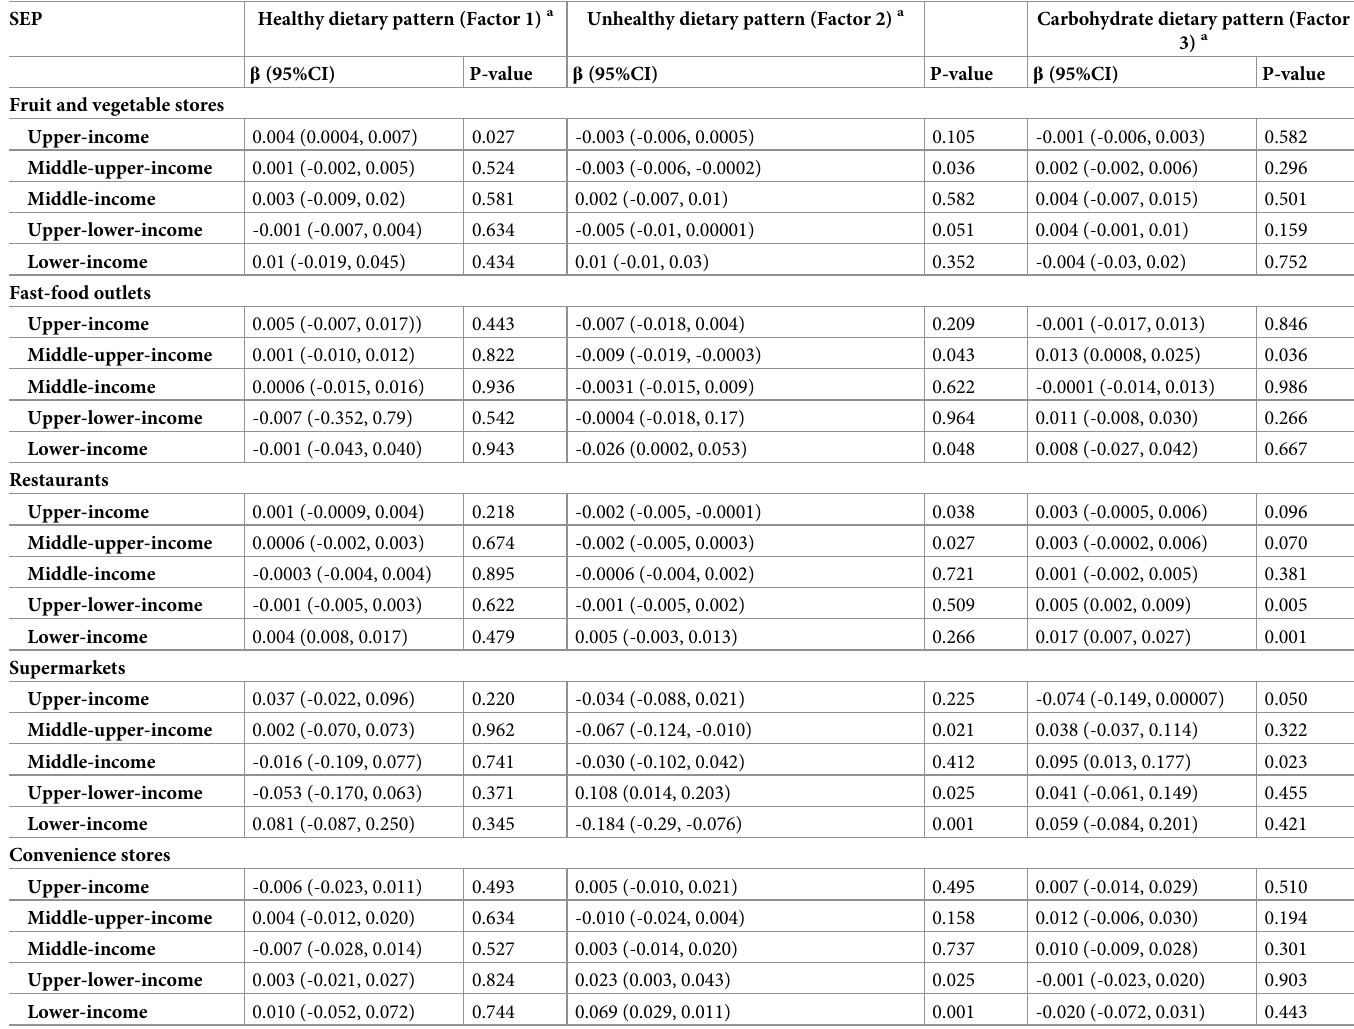
Table 5. Association of dietary pattern and food outlet density, stratified by household SEP.